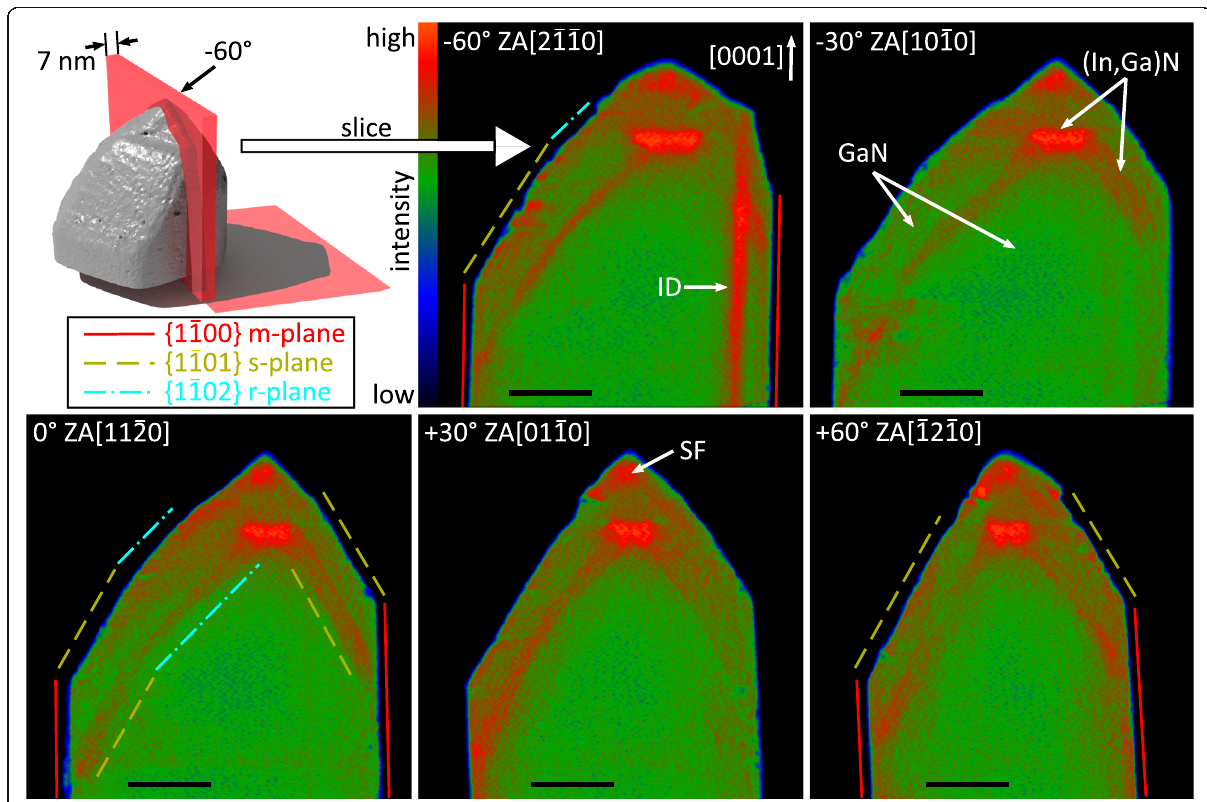
Fig. 4 Cross-sectional slices through the tomogram. A 3D rendered representation of the NW and a slice (upper left corner) specifies the spatial position of the − 60°-tilted slice. All slices are rotated around an axis which pierces through the NW tip and which is parallel to the [0001] NW growth axis. An inversion domain (ID) and the location of stacking faults (SF) are labeled. The slice orientations correspond to the labeling of Fig. 3. The length of the black scale bar corresponds to 50